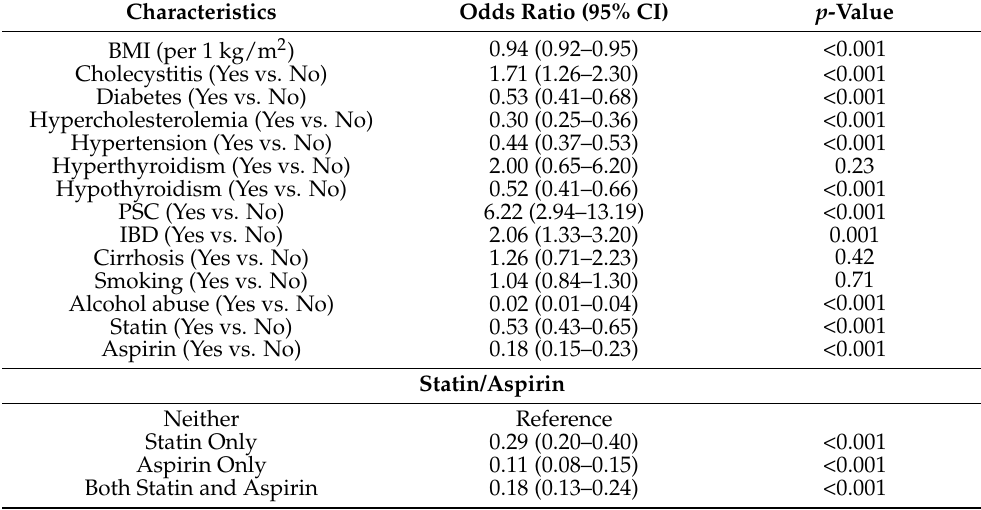
Table 2. Univariable analysis of the factors evaluated for their association with gallbladder